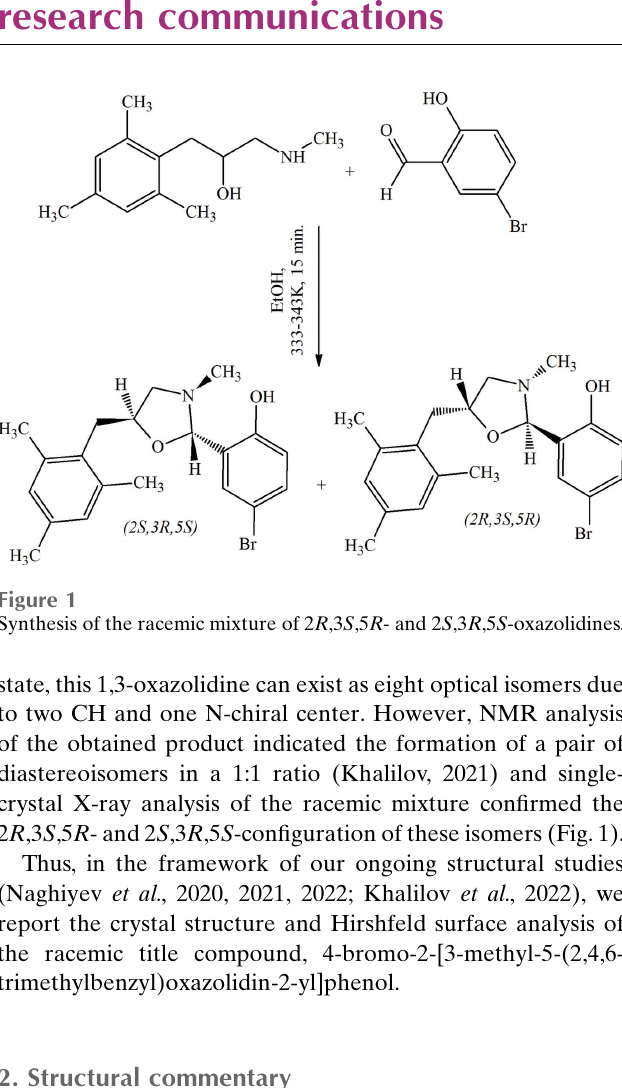
Figure 2 The molecular structure of the title compound. Displacement ellipsoids are drawn at the 50% probability level.